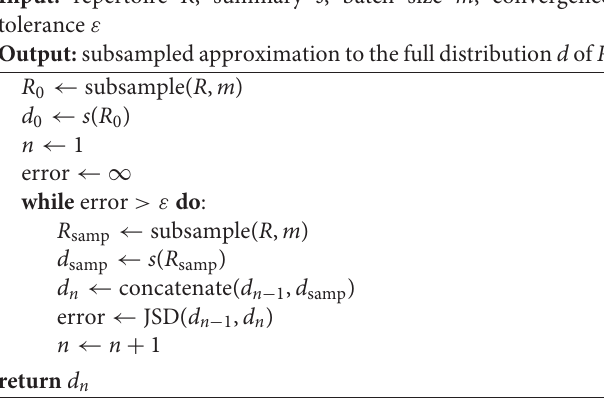
Algorithm 1: Compute automatic approximate